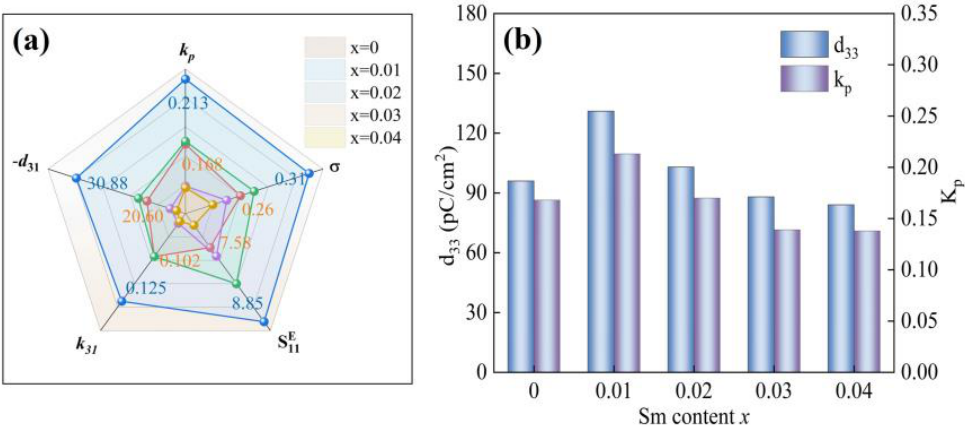
Figure 7. ( a ) Electromechanical coupling parameters of porous BNBT6- x Sm ceramics. ( b ) Variation d 33 and k p of porous BNBT6- x Sm ceramics with x. Table 1. Electromechanical coupling parameters of porous BNBT6- x Sm ceramics.